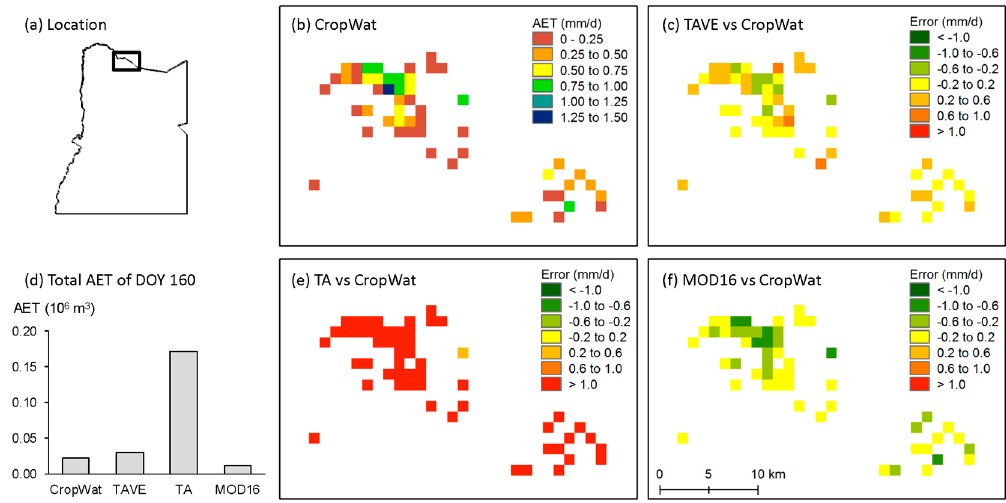
Figure 10. Comparison of different daily AET estimates for an irrigated region on April 9th (DOY 160) of 2009. ( a ) shows the location of the Yarmouk River Basin. ( b ) presents the pixel-level AET estimate (mm/day) calculated by the single crop coefficient method using CropWat, assumed to be a proxy for the ground truth. ( c ) shows the absolute error of the estimates by TAVE to ( b ). ( d ) compares the basin-wide total AET estimates (10 6 m 3 /day) calculated by multiplying the pixel-level AET rate (mm/day) by the size of a pixel (km 2 ). ( e , f ) show the absolute errors of the estimates by TA and MDO16 to ( b ), respectively.